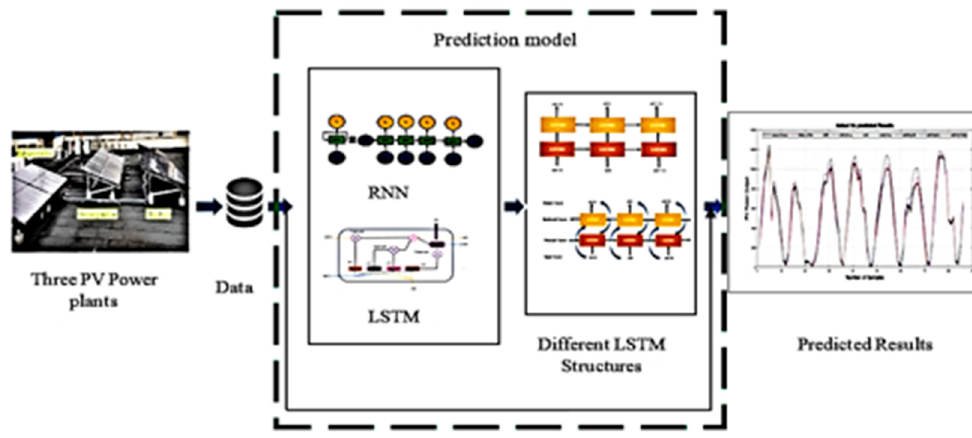
Figure 1. The proposed methodology research